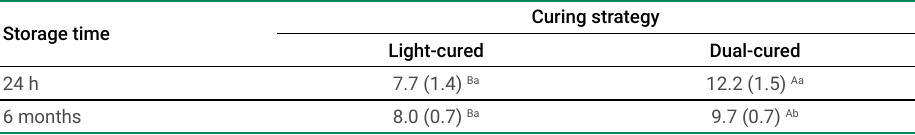
Distinct uppercase letters indicate statistically significant differences between curing strategies for the same storage time (p<0.05). Distinct lowercase letters indicate statistically significant differences between storage times for the curing strategy (p<0.05).